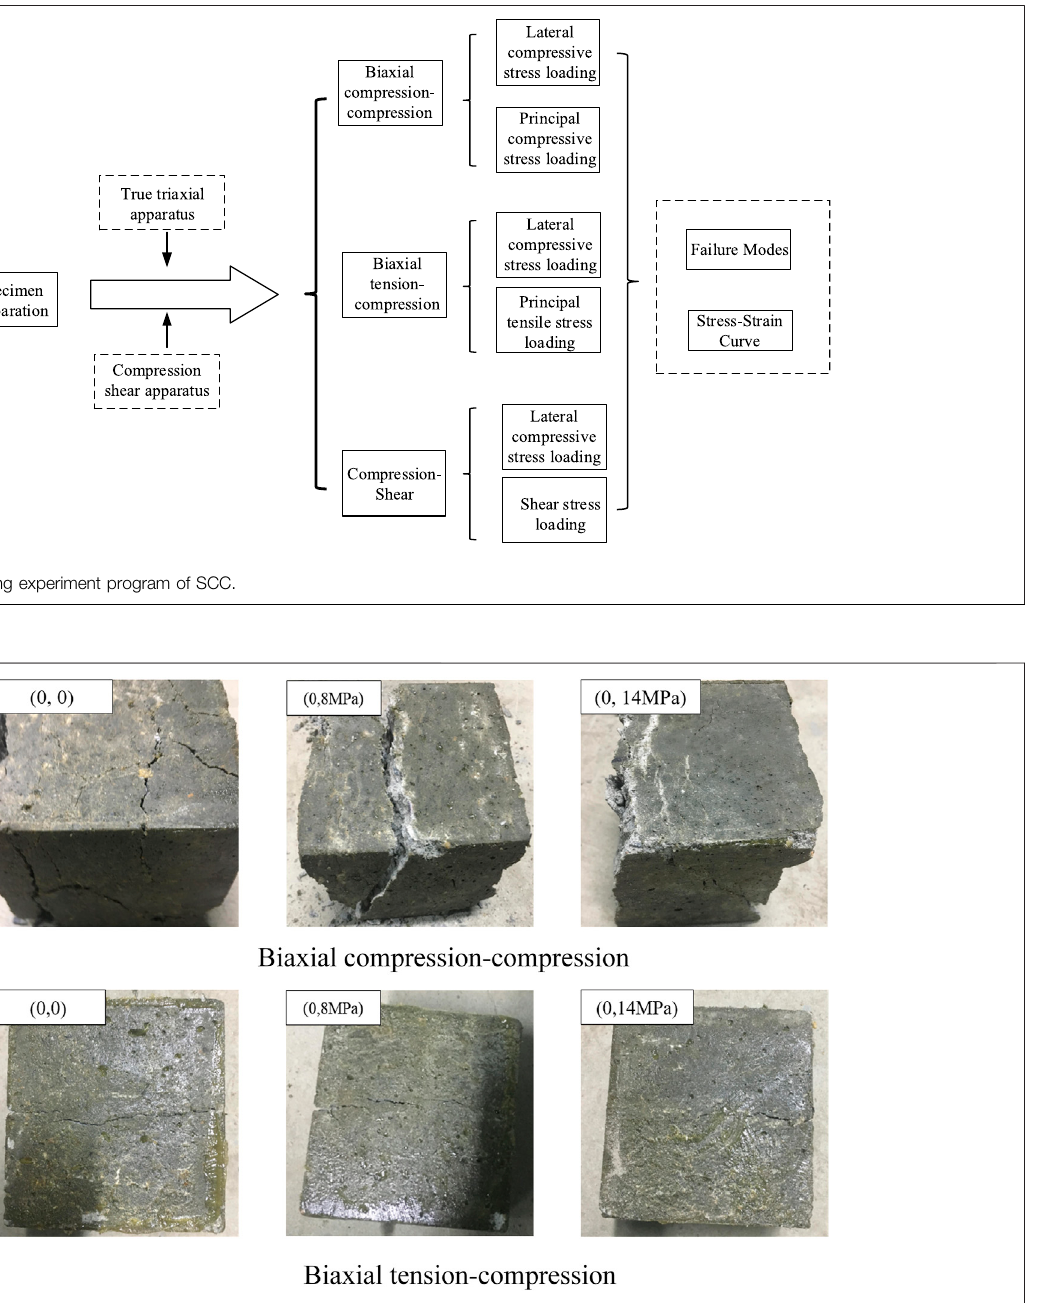
FIGURE 4 | SCC failure modes under biaxial loading. (A) Biaxial compression-compression. (B) Biaxial tension